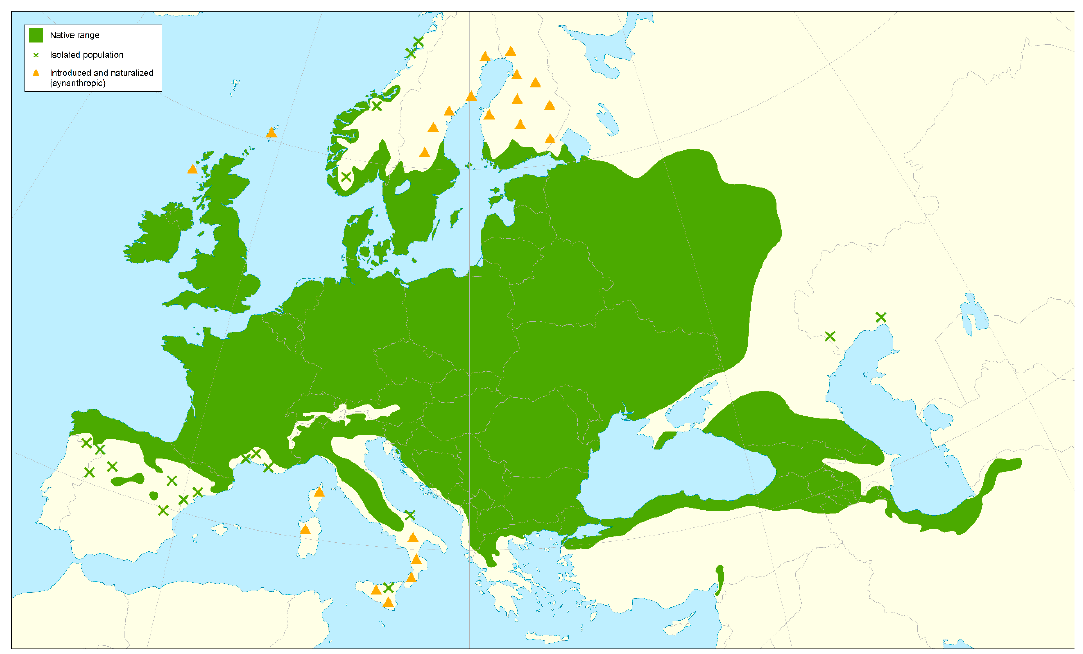
Figure 7. Fraxinus excelsior distribution map [62]. https://commons.wikimedia.org/wiki/File:Fraxinus_excelsior_range.svg